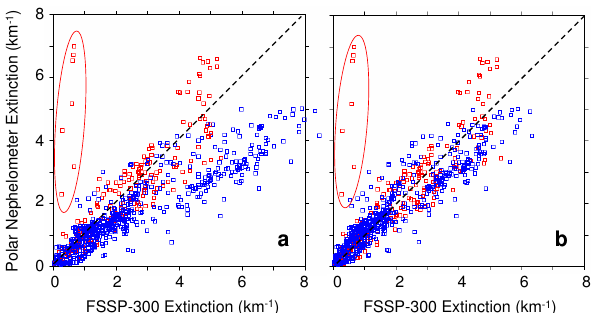
Fig. A1. Comparison of extinction coefficients derived from FSSP- 300 and from Polar Nephelometer (PN) measurements. FSSP-300 with different size calibrations: (a) for spherical particles, (b) for spherical (red data) and aspherical (blue data) depending on the value of the PN-derived asymmetry parameter g . The red and blue square symbols refer to asymmetry parameter values g > 0 . 85 and g < 0 . 85,